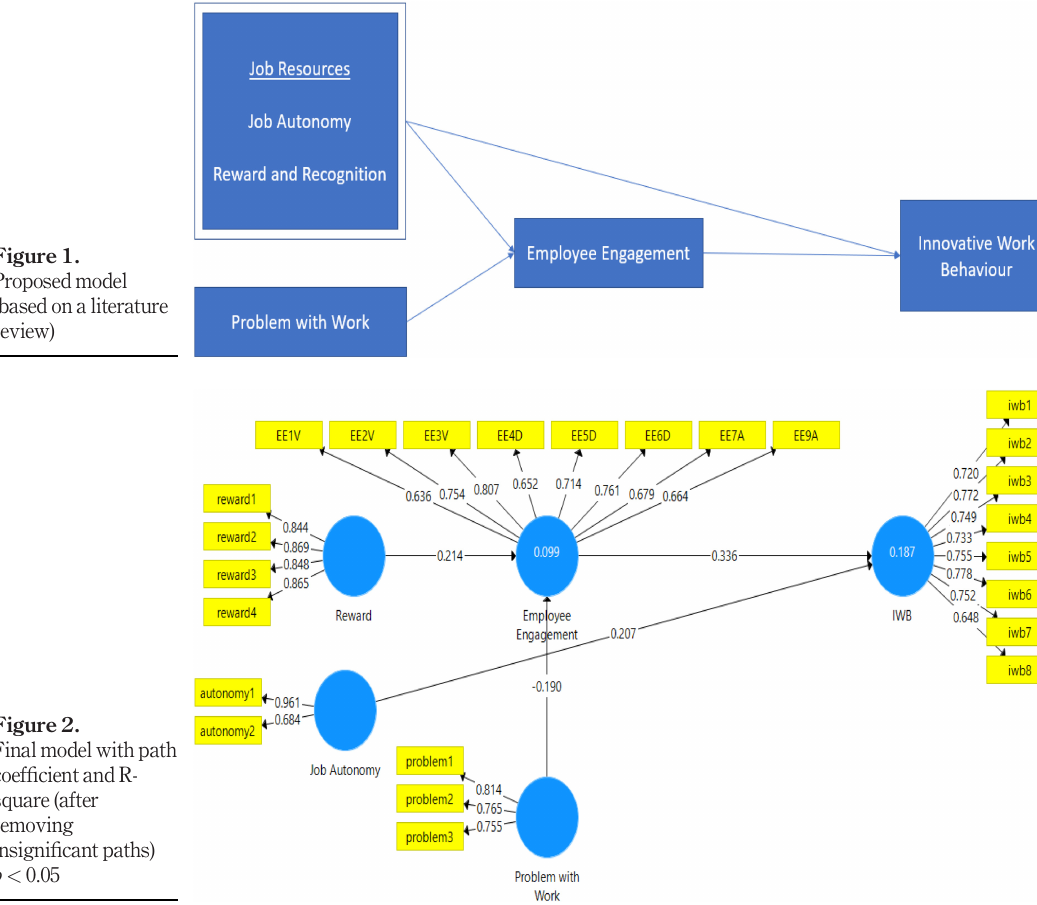
Figure 1. Proposed model